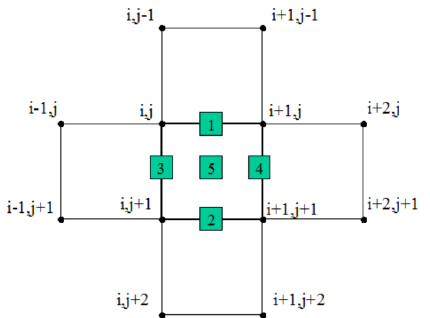
Figure 2. Disposition of the cells to compute the prediction operator G L + 1